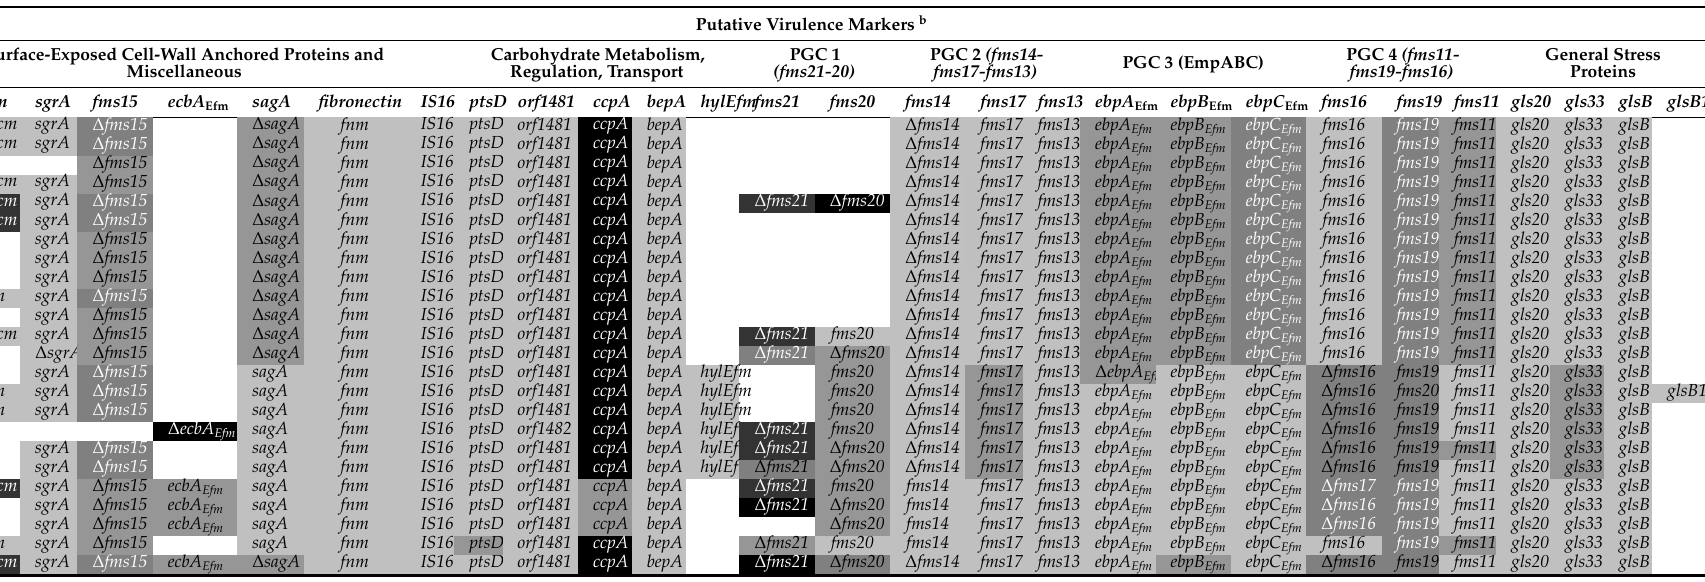
Table 2. Epidemiological data and virulence gene content in the 24 analysed strains.